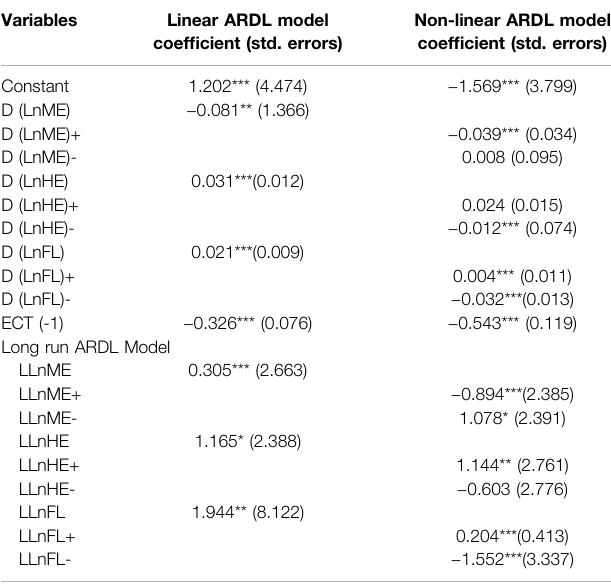
TABLE6| Shortrunandlongrunestimatesbasedontheselectedlinearandnon- linear ARDL Model. Variables